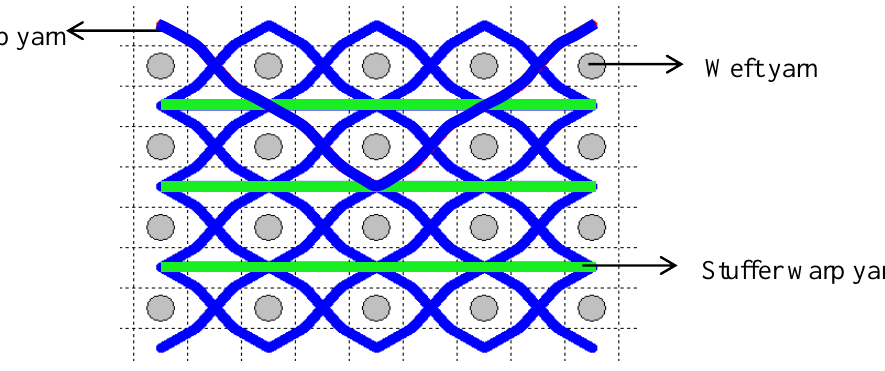
Figure 7. Example of the contact surface between the stuffer and weft yarns (in F1 fabric structure).